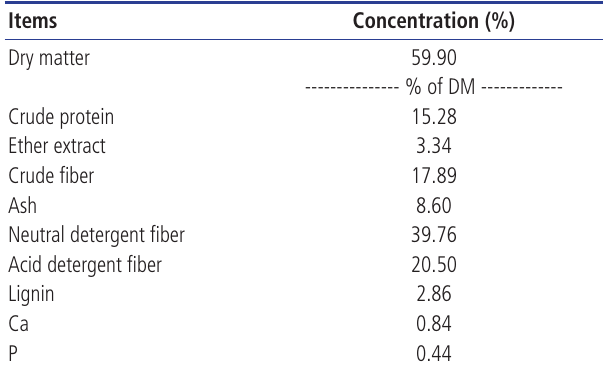
Table 1. Chemical composition of experimental diet